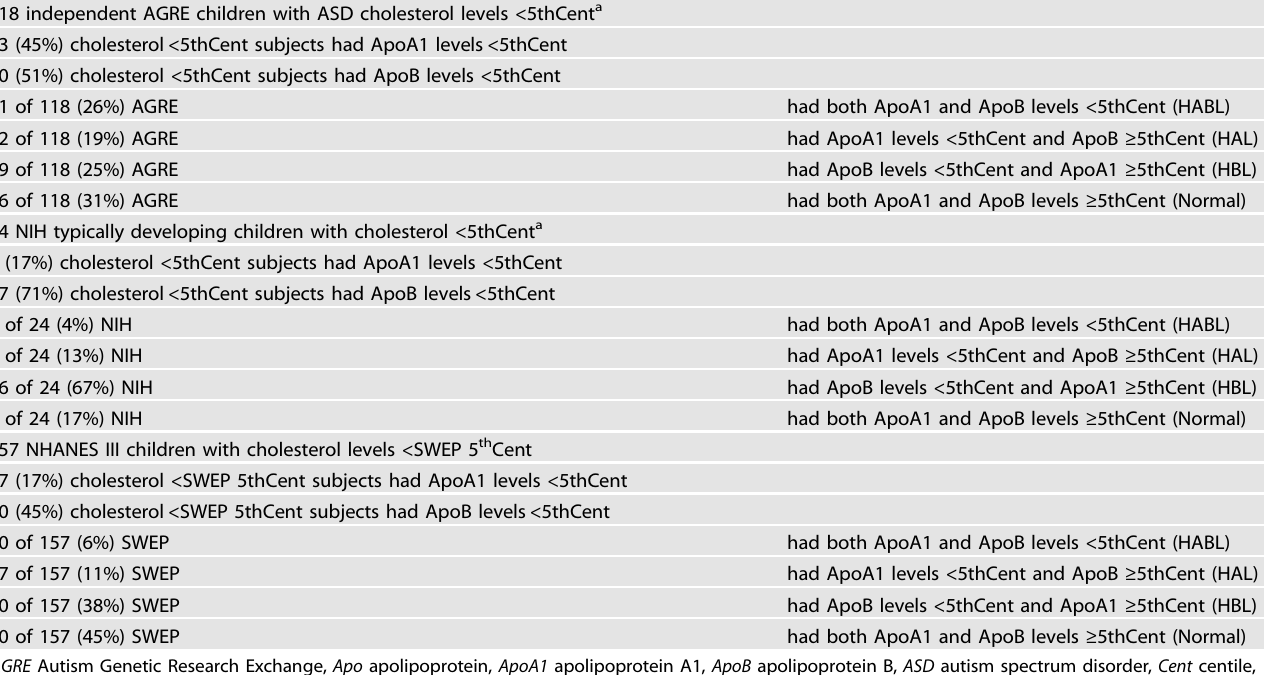
Table 1. Apolipoprotein patterns in AGRE, typically developing, and NHANES-III subjects ’ age 4.0 – 17.9 years with cholesterol levels less than the 5th